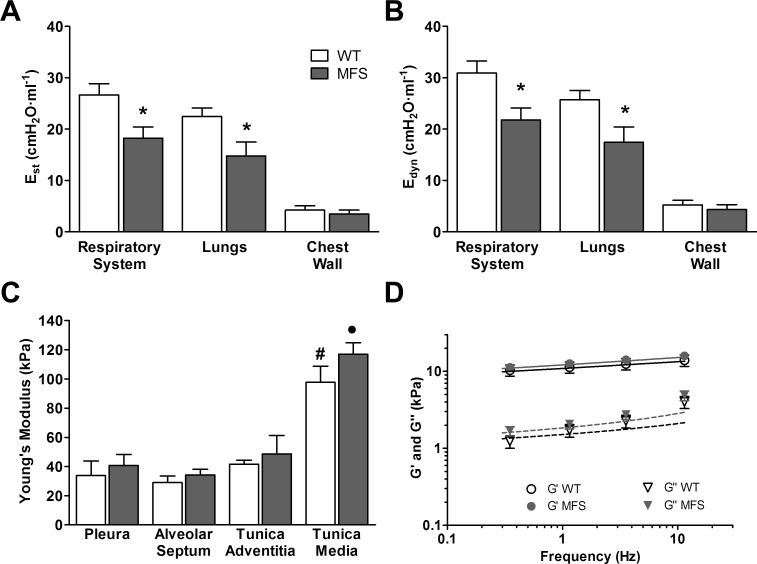
Mechanics in 9-month old mice.(A) Static (Est) and (B) dynamic (Edyn) elastances in WT (white column) and Marfan mice (grey column) determined by the end-inspiratory airway occlusion method. *: p < 0.05 when comparing WT and Marfan. (C) Young’s modulus (E) measured at different regions of the lung ECM in WT (white column) and Marfan mice (grey column). #: p < 0.05, and •: p < 0.05 when comparing different regions in WT and Marfan, respectively. (D) Complex shear modulus (G*) measured at the alveolar septum of decellularized lung matrix in WT (open symbols) and MFS (closed symbols) mice. Circles represent the real part (storage modulus, G’) and triangles represent the imaginary part (loss modulus, G”) of G*. Solid and dashed lines represent fits of the two power law model to G’ and G”, respectively (WT black and MFS grey). Data are mean ± SE.